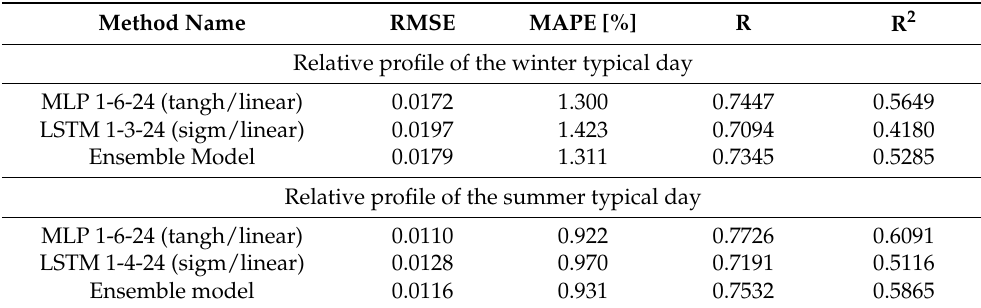
Table 6. Summary of forecast relative profiles of typical days for three models (error metrics) within the models’ parameter estimation range (2009–2021).